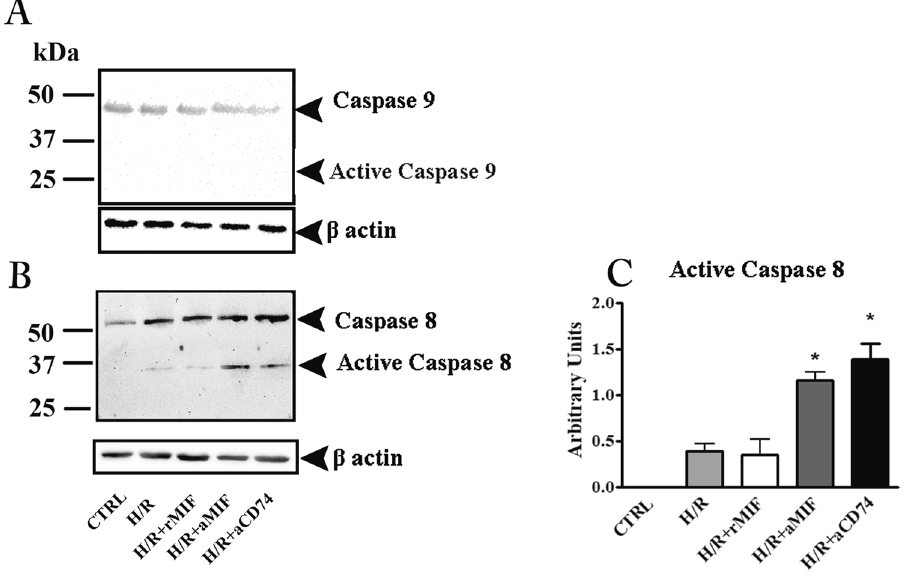
Figure 5. Hypoxia/re-oxygenation (H/R) apoptosis is via caspase-8 in placenta explants. Representative western blots for caspase-9 ( A ) and caspase-8 and the associated densitometric analysis ( B and C ) in explant cultures exposed to H/R. CTRL: control explant cultures ; H/R + rMIF at 100 ng/mL (H/R + MIF); H/R + anti- human MIF antibodies at 10 µ g/mL (H/R + aMIF) or anti-human CD74 antibodies at 5 µ g/mL (H/R + aCD74). * p < 0.05 (n = 4 placentae at 8–10